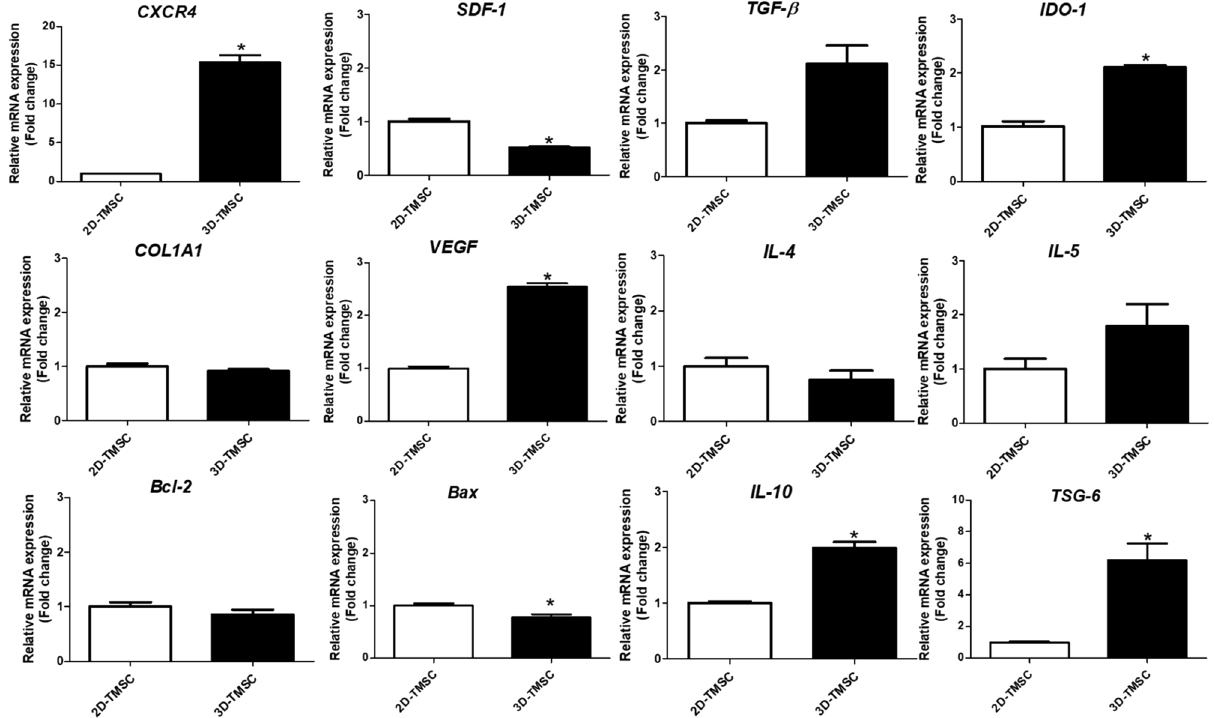
Figure 2. Expression of cytokines in 3D-cultured TMSCs. The expression of anti-inflammatory cytokines, including IL‑10 and TSG‑6, were significantly higher in 3D-cultured TMSCs than in 2D-cultured TMSCs as analyzed using qRT-PCR (*P < 0.005). 3D, three-dimensional; TMSCs, tonsil-derived mesenchymal stem cells; IL-10, interleukin 10; TSG-6, tumor necrosis factor-stimulated gene 6; qRT-PCR, quantitative reverse transcription quantitative polymerase chain reaction; CXCR4, C-X-C motif chemokine receptor 4; SDF-1, stromal cell-derived factor 1; TGF-β, transforming growth factor β; IDO-1, indoleamine 2,3-dioxygenase 1; VEGF, vascular endothelial growth factor; BCL-2, B-cell CLL/lymphoma 2; BAX, BCL2 associated